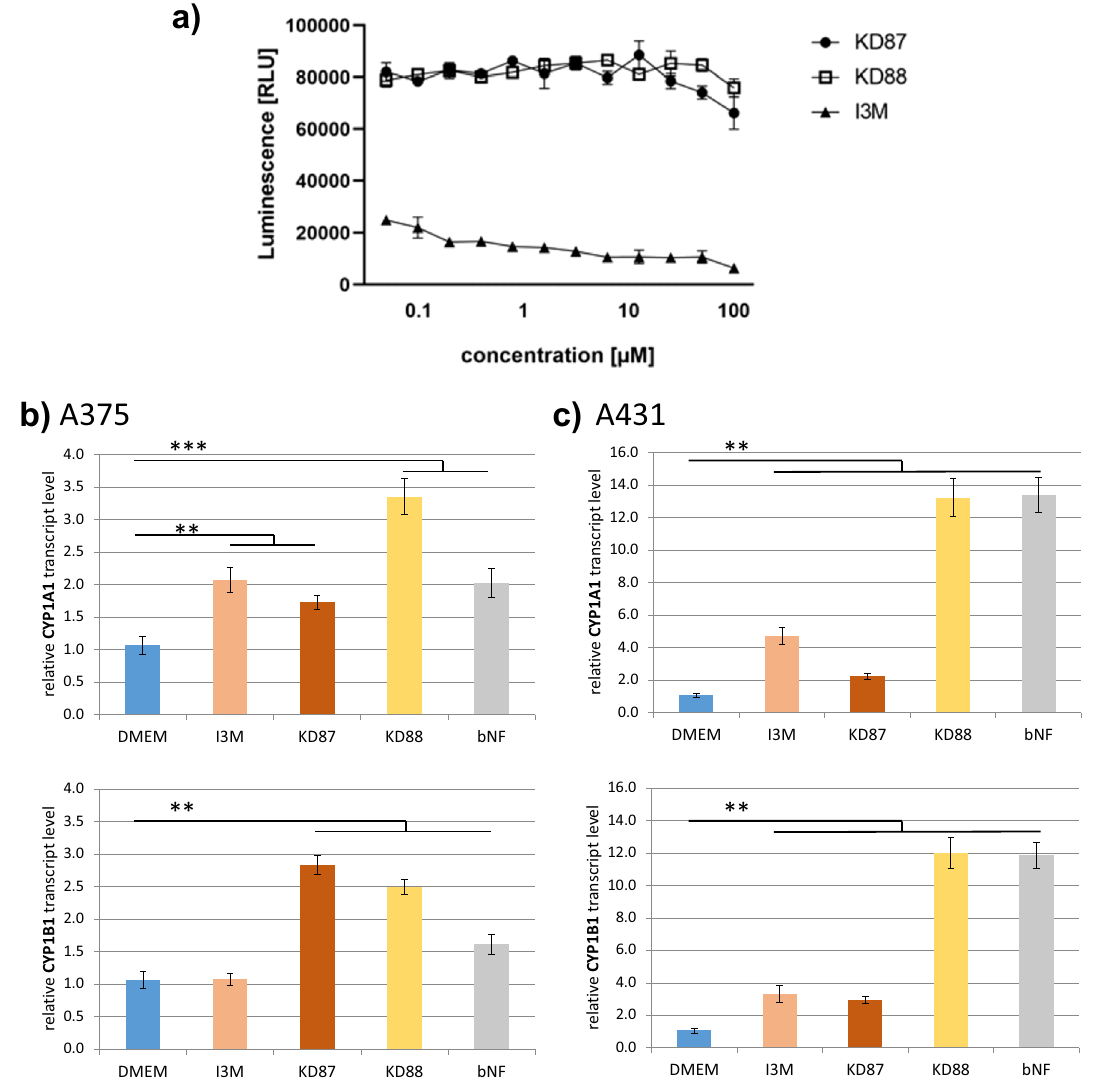
Figure 8. ( a ) Inhibiton of GSK-3β by KD87, KD88 and I3M (Dose–response curves/ADP-Glo kinase assay). Transcript level of the CYP1A1 and CYP1B1 genes in A375 ( b ) and A431 ( c ) after 6 h incubation with small molecules. In both cell lines, we observe a significant induction of CYP1A1 transcript level by KD87, KD88 and bNF. CYP1B1 transcript levels were significantly increased by KD87 but not by I3M in A375 cells, whereas we found induction by all compounds in A431 cells. ß-Naphthoflavone (bNF, 20 µM) was used as positive control. Note the different scale of the y-axis in ( b ) and ( c ), indicating a more pronounced increase in transcript levels in A431 cells. (*Wilcoxon matched-pairs signed rank